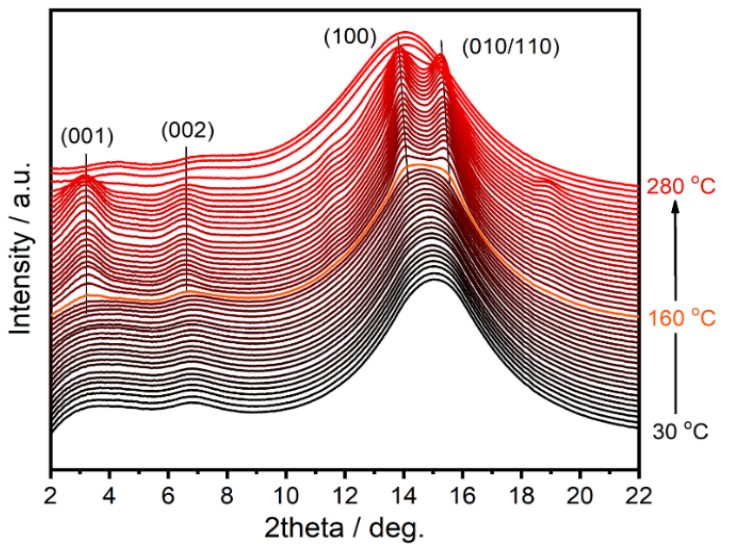
Figure 2. 1D-integrated wide-angle X-ray diffraction (WAXD) curves of PAPACM12 in the heating process. Table 2. The position of diffraction peak and corresponding d -space in 1D WAXD curves under 164 ◦ C.